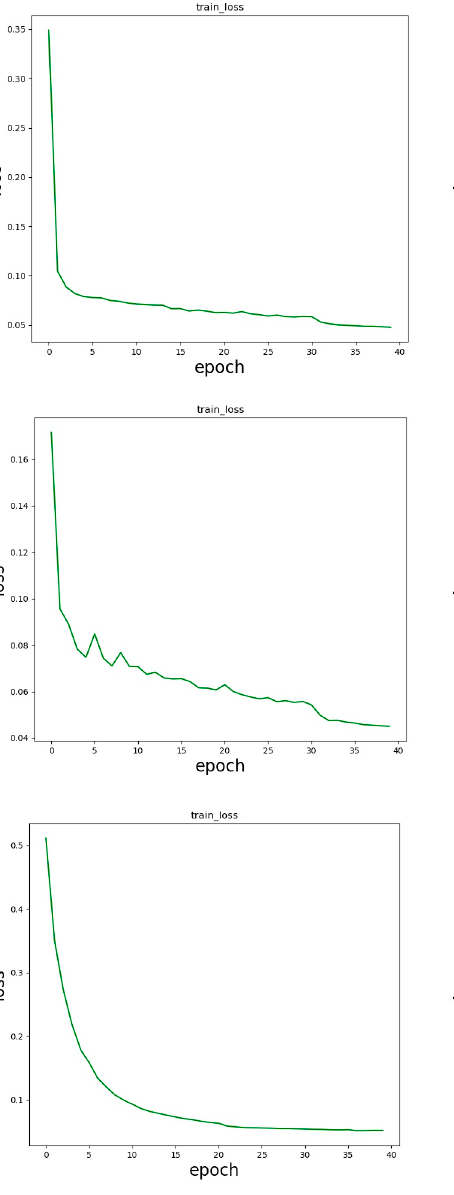
Figure 10. Loss and MIoU of the four networks during